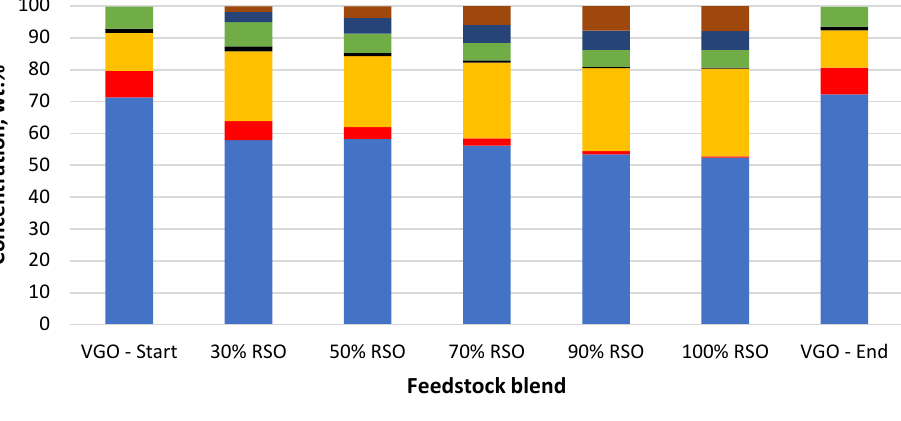
Figure 6. Composition of the main gaseous products collected for each feedstock blend processed using the NiW/A ‐ Ph catalyst.